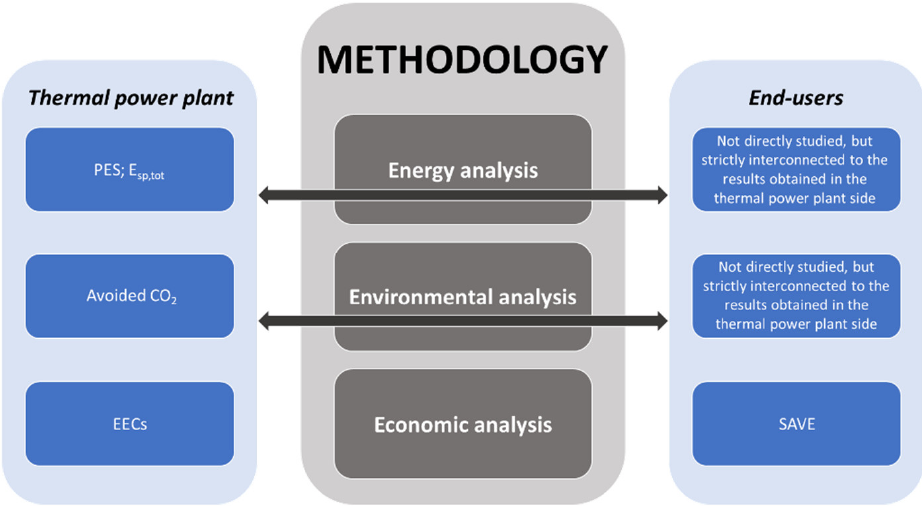
Figure 6. The flow chart of the methodology used in both thermal power plant and end-users’ side.